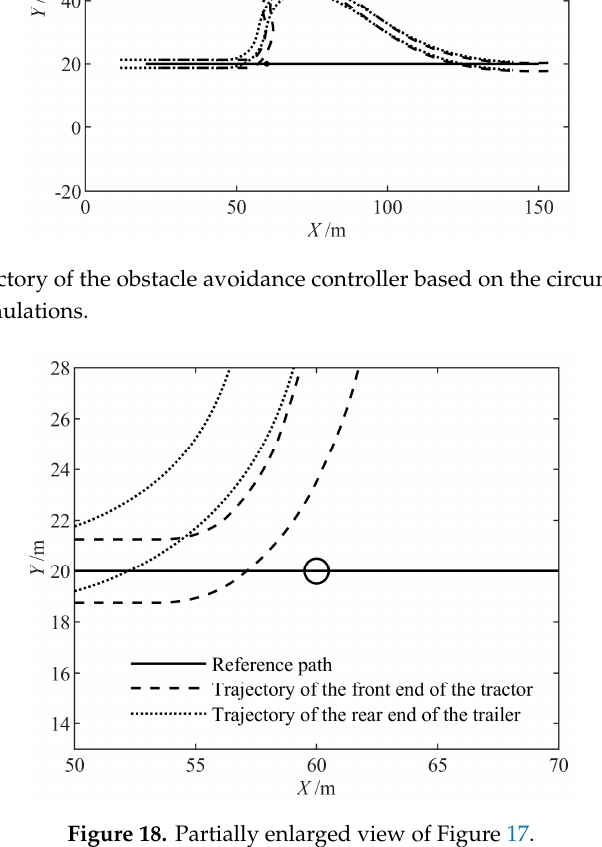
Figure 18. Partially enlarged view of Figure 17.